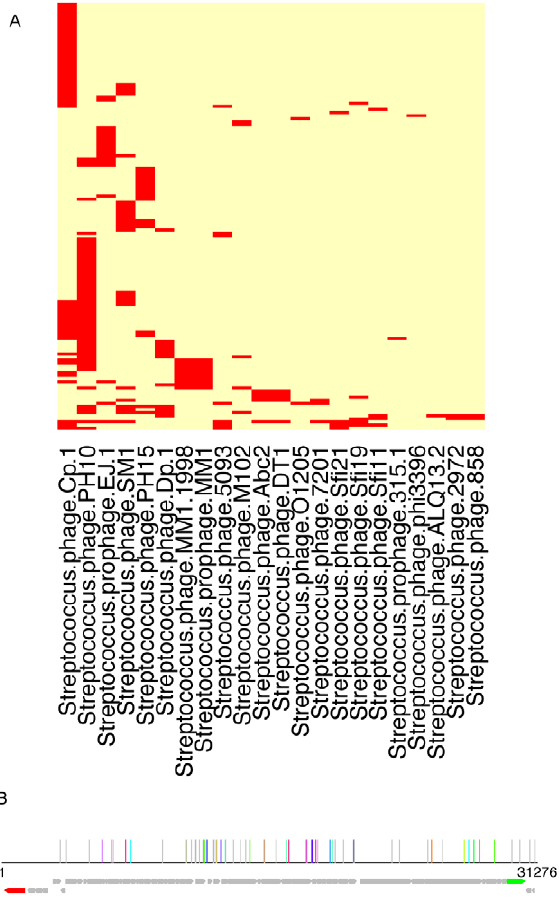
Figure 6. Traces of viral sequences in the streptococcal CRISPRs in human microbiomes. (A) A two-way clustering of viral genomes and the HMP datasets based on the presence patterns of viral sequences in the CRISPR loci identified in the HMP datasets: the columns are the viral genomes, and the rows are HMP datasets. It shows that the genome of Streptococcus phage PH10 (NC_012756) has the most regions that are similar to the spacers in streptococcal CRISPRs. This figure was prepared using the heatmap function in R, with the default clustering method (hclust) and distance measure (Euclidean). (B) Mapping of the spacers onto the 31,276 base genome of Streptococcus phage PH10; in this figure, each vertical line shows a potential proto- spacer, a region in the virus genome that is similar to a spacer found in HMP datasets; lines of the same color show sets of proto-spacers identified from the same HMP dataset (other individual proto-spacers are shown in gray lines); the ORFs are shown in arrows (the red arrow is an integrase and the green arrow is annotated as endolysin).